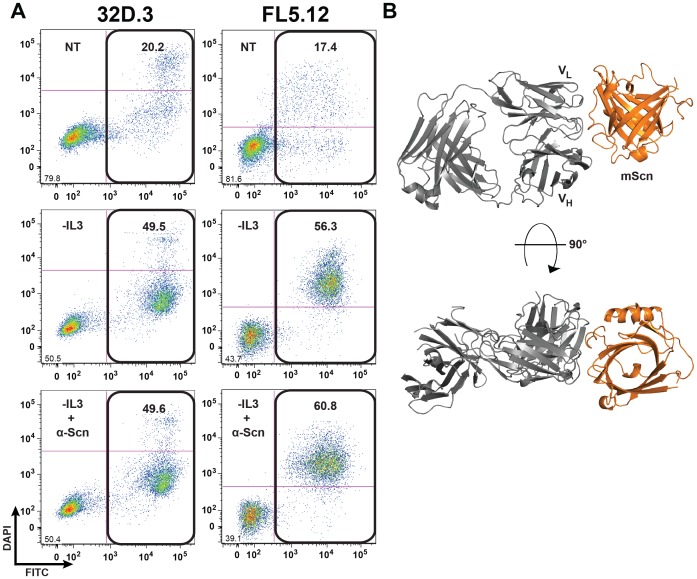
An anti-Scn antibody does not block IL-3 withdrawal-induced apoptosis.(A) 32D.3 and FL5.12 cells in the presence (NT) or absence (-IL3) of IL-3 were incubated for 48 h with 10 µM of the anti-Scn antibody MAB1857; percent annexin-V positivity is indicated. (B) The structure of Fab MAB1857 with Scn, shown in a ribbon representation (Fab in gray and Scn in orange), reveals the interface that is occluded in the complex. Had Scn had an effect on apoptosis through receptor-mediated uptake, the effect of the antibody on the process would have identified a potential receptor-interacting surface on Scn, the rationale for this approach. However, since Scn does not affect apoptosis, an anti-Scn antibody cannot reveal a receptor-interacting surface by blocking a non-existent effect.